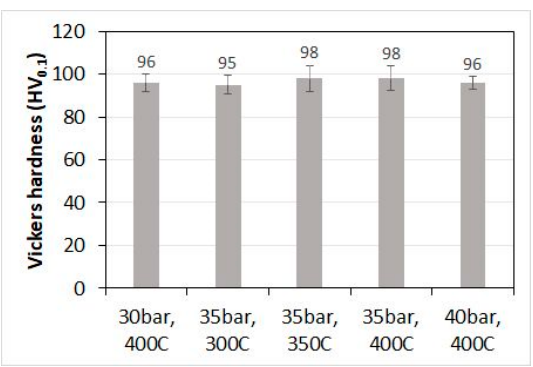
Figure 9. Vickers hardness (HV 0.1 ) and standard deviations of the cold-sprayed Al6061 coatings sprayed with different spray parameters.